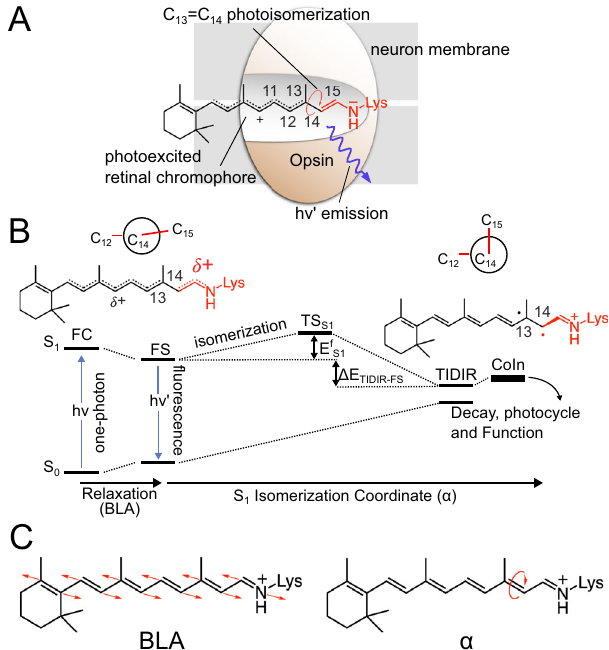
Fig. 1 | Photoisomerization mechanism of Archaerhodopsins. A Lewis formula representing the initial S 1 chromophore structure. B Representation of the chro- mophore isomerization path. FS corresponds to the fl uorescent state. TIDIR represents the photoisomerization channel located near CoIn. FS and TIDIR are representedbyLewisformulasdisplaying distinctdegreesof doublebond twisting and charge transfer. C Main components of the reaction coordinate. BLA is numerically de fi ned as the difference between the average single-bond length minus the average double-bond length along the C5 to N conjugated chain (for convenience, below we consider the BLA of the framed moiety exclusively). α is de fi ned by the dihedral angle